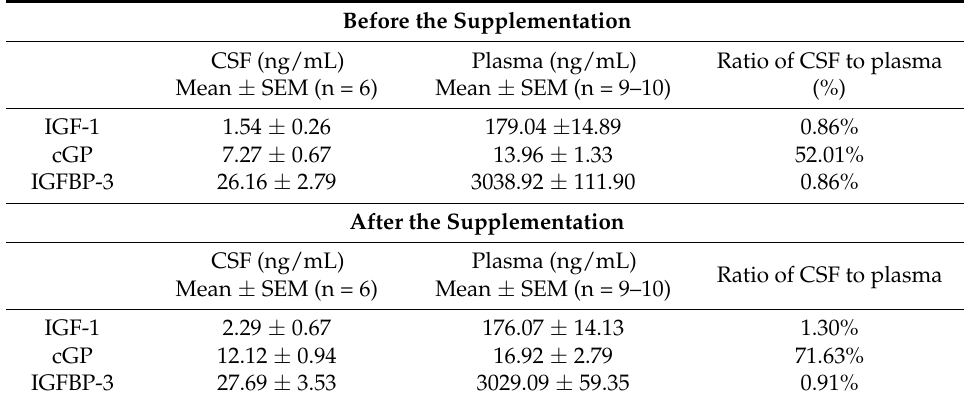
Table 2 CSF and plasma concentrations of cGP, IGF-1, and IGFBP-3 before and after BCA supplementation.